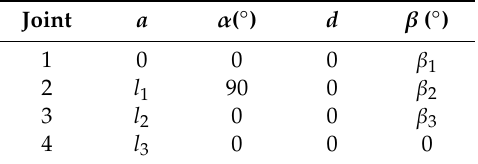
Table 1. Denavit–Hartenberg (D-H) parameters of a hexapod leg link.